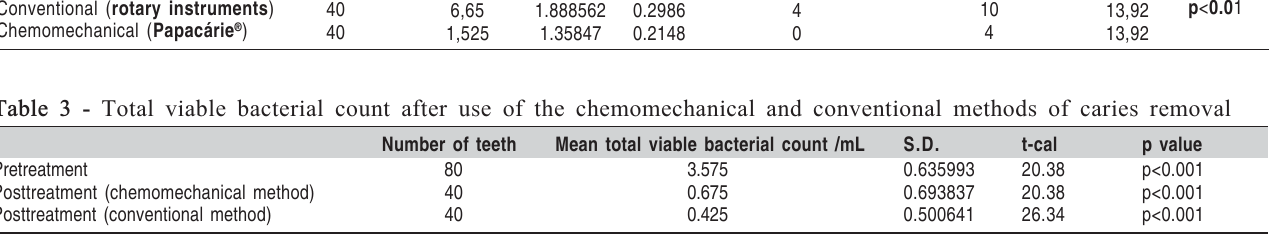
Table 1 - Mean value of time taken for caries removal in both groups. Caries removal method Conventional ( rotary instruments )